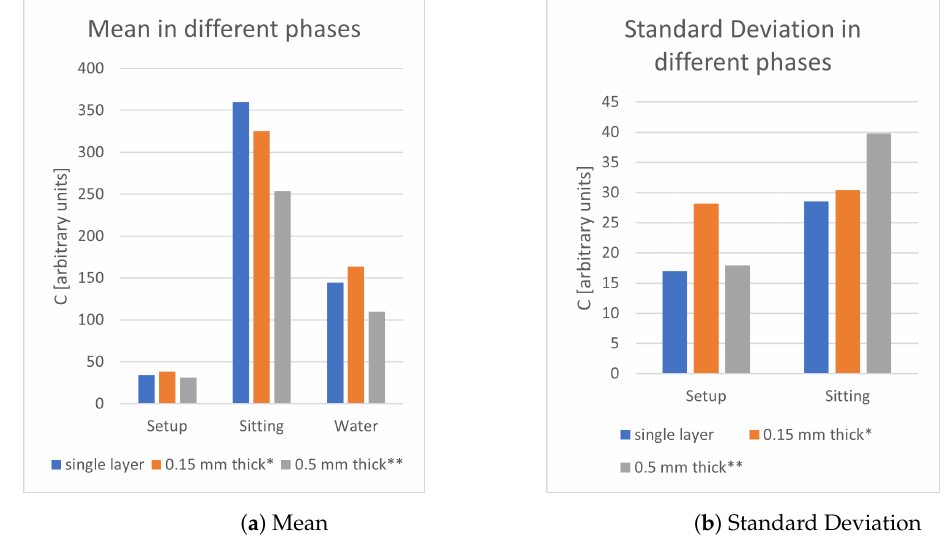
Figure 3. Study of different thickness of sensing plates. * Auto-calibration occurred during water frames; ** Auto-calibration occurred both in water and sitting